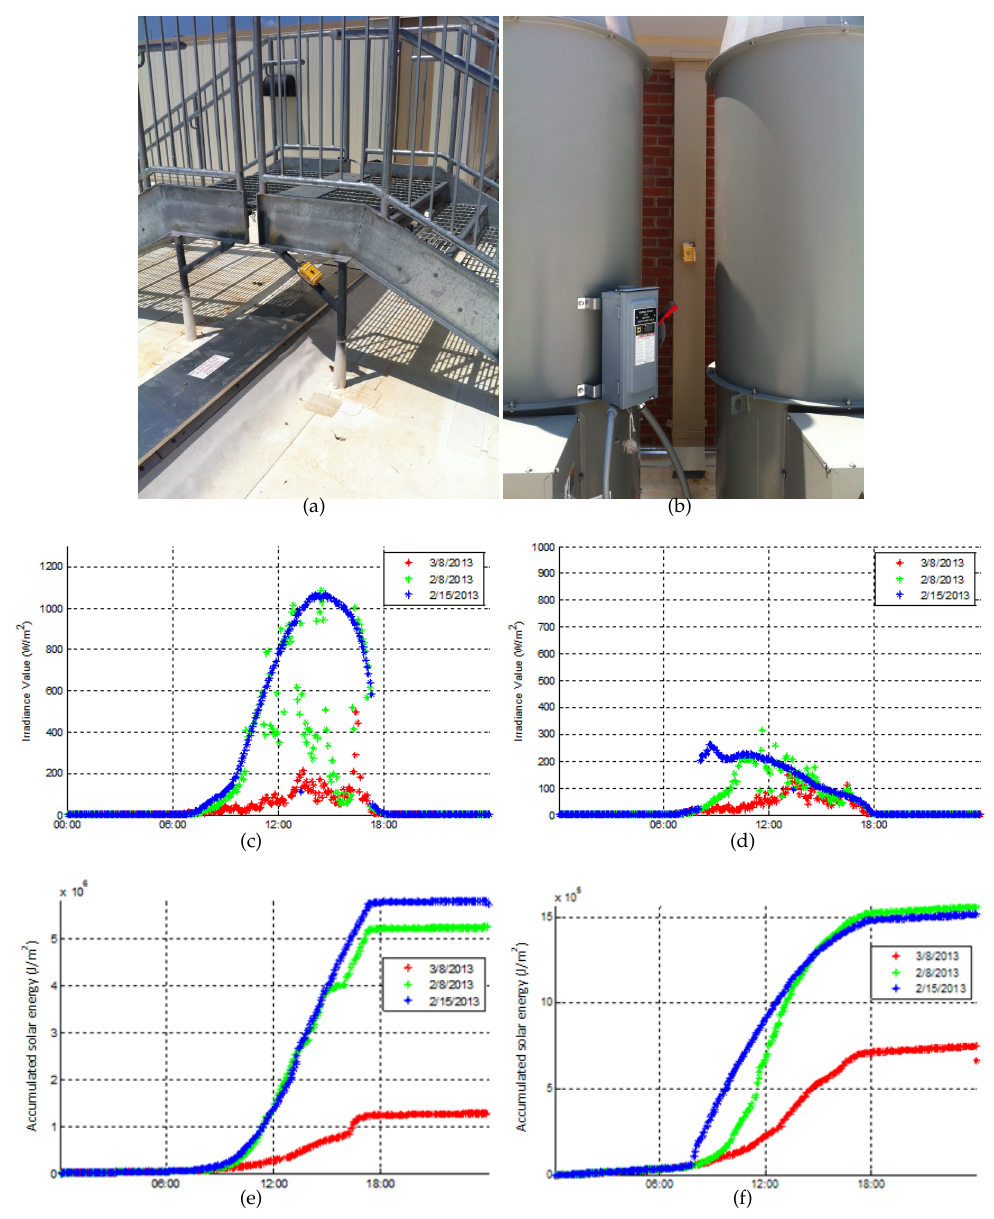
Figure 4. Samples of nodes deployed in EPIC-RoofNet : ( a ) Node 153 ( b ) Node 157. Irradiance measurement of node 153 ( c ) and node 157 ( d ) for two sunny days (8 and 15 February 2013) and a cloudy day (8 March 2013). Node 157 is kept in the shaded region, whereas 153 receives sunlight most of the time. Accumulated solar energy of these two nodes for three different days ( e , f